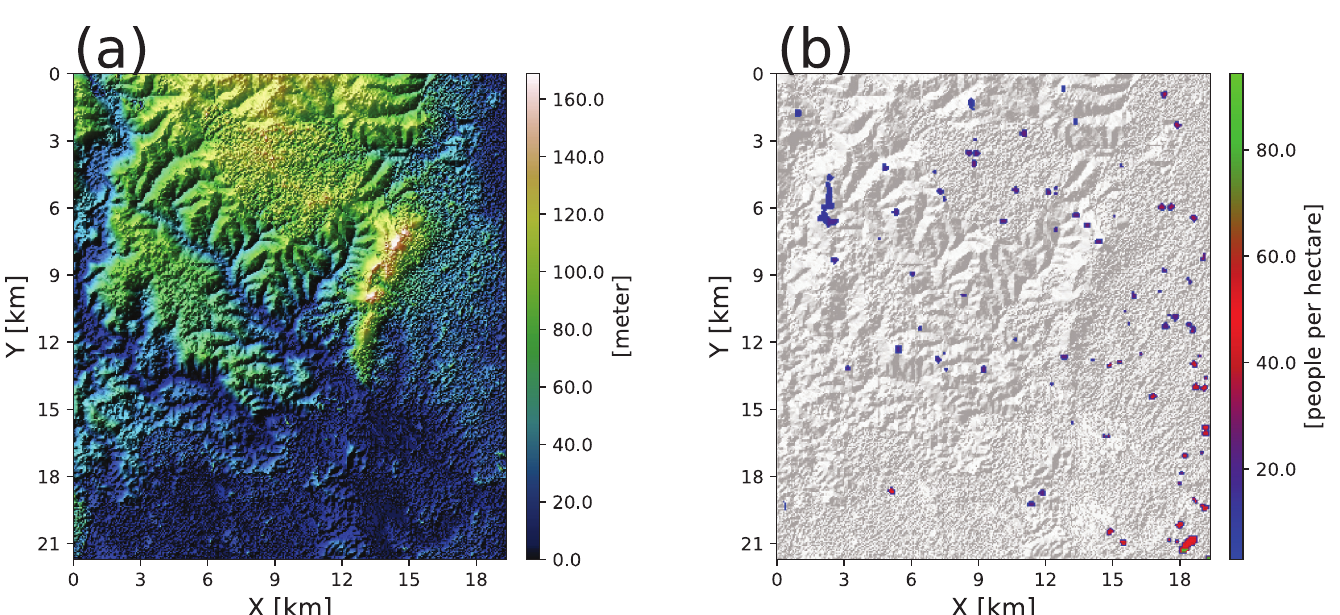
Fig 3. Domain of simulations in the study area. (a) Variation in topographic elevation (source: ASTER DEM). (b) Map of distribution of human population in the study area (source: [56]). The gray background represents hillshaded topography.